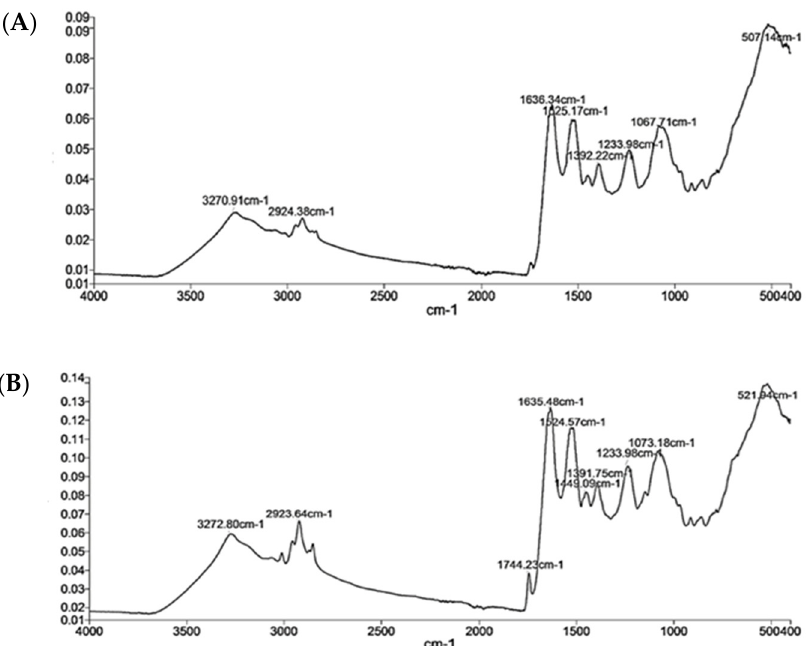
Figure 3. Fourier transform infrared (FTIR) spectra of thraustochytrid protein isolates obtained from two strains, MAN65 ( A ) and MAN70 ( B ).